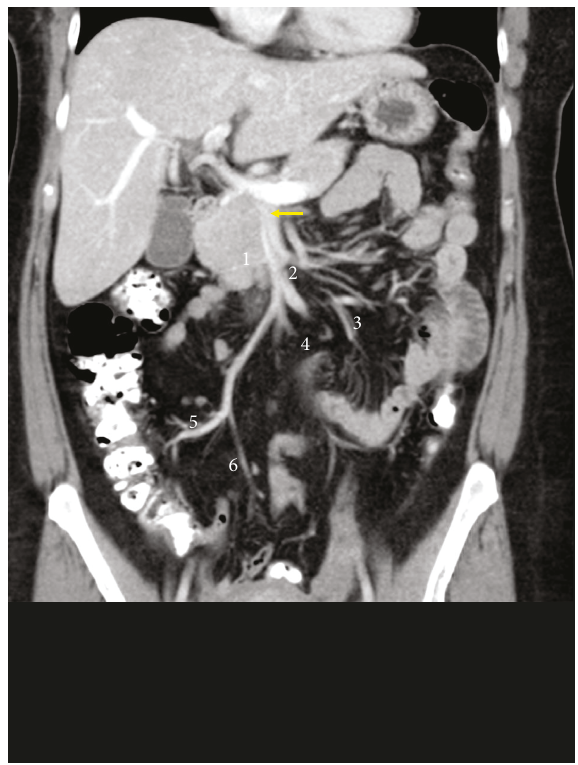
Figure 2: Ramifications of the superior mesenteric artery (arrow) include the inferior pancreaticoduodenal (1), middle colic (2), jejunal (3), ileal (4), right colic (5), and ileocolic arteries